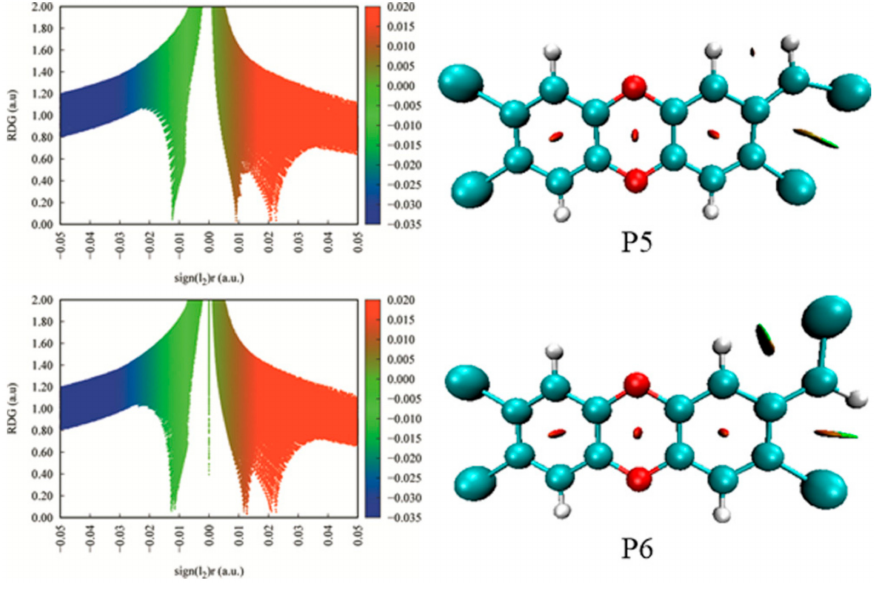
Figure 7. RDG analyses for products P5 and